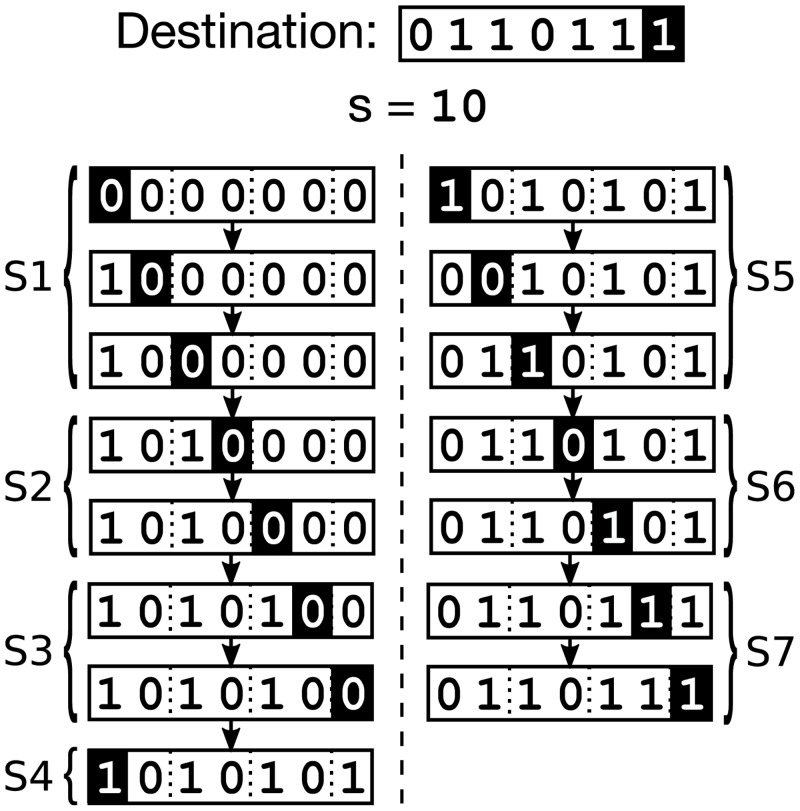
An example of one path as constructed by the proposed multipath routing algorithm.The path is shown for s = 102 and w = (6, 01101112).